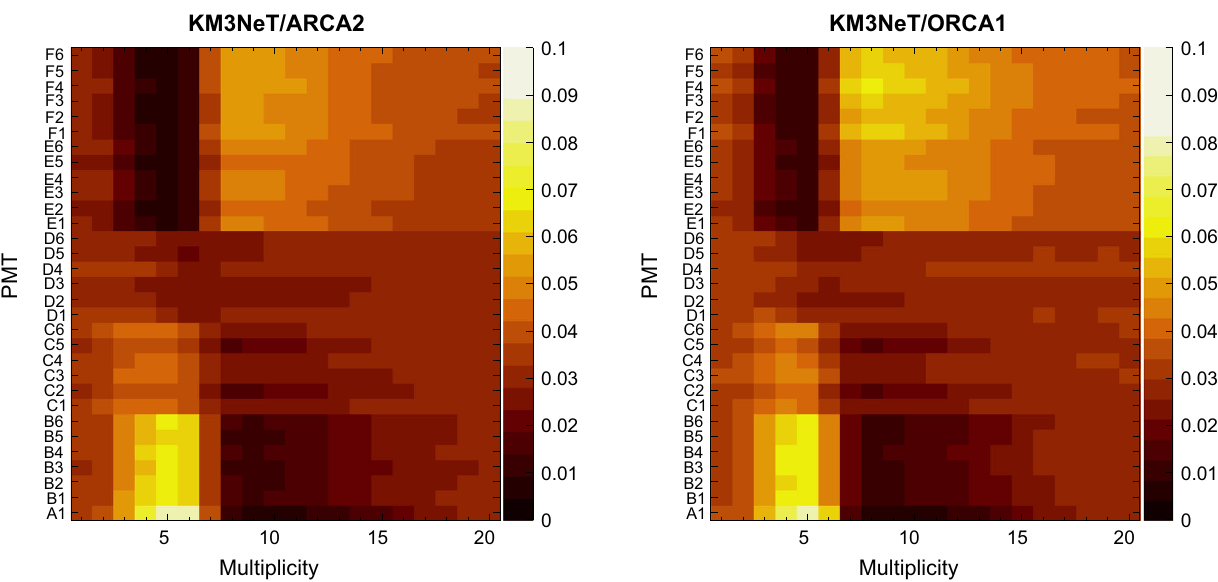
Fig. 7 Probability density function of each PMT contribution to coin- cidence rates as a function of the multiplicity (each abscissa bin is normalised to unity). The PMT is identified by the ring (letter) and the position of the PMT on the ring (number). The first address (A1) refers